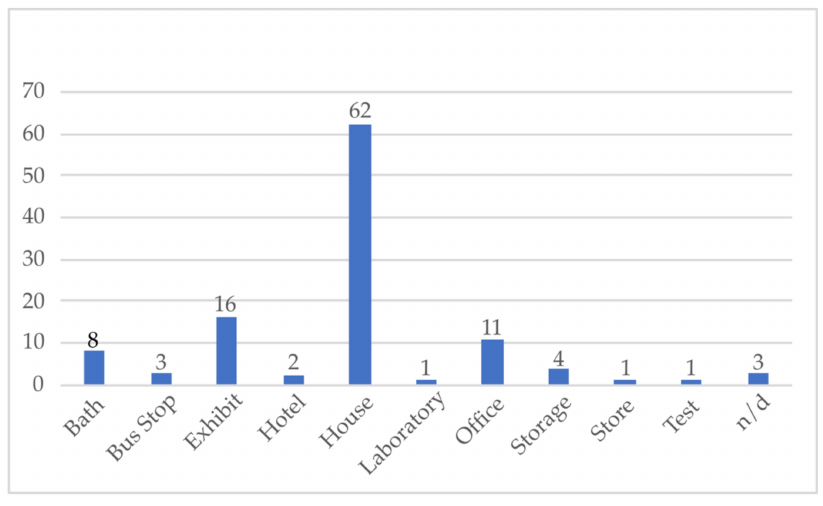
Figure 5. Number of 3D-printed constructions by functions (n/d: no